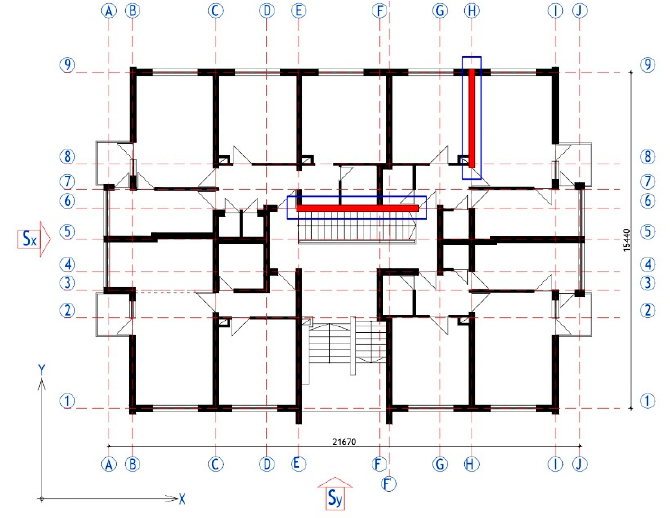
Figure 11. A plan view showing the walls used for the code comparison. Table 7. Verification of shear capacity for longitudinal and transverse direction (selected walls). Longitudinal (X)